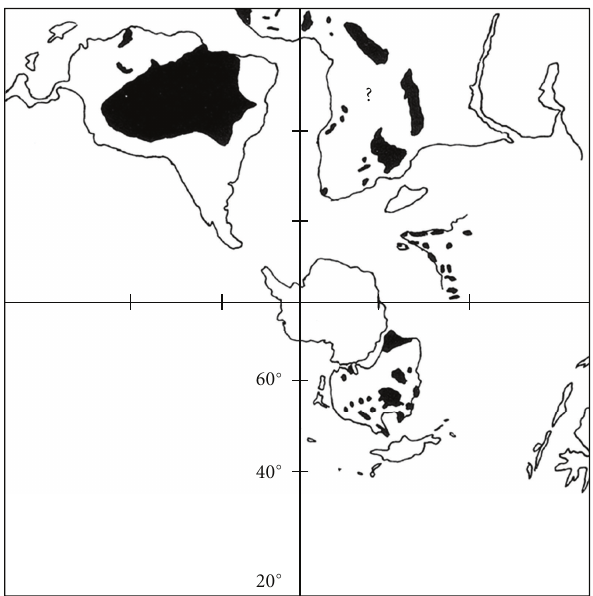
Figure 1: Distribution of lateritic soils (latosols) on the continental masses of Gondwanaland ([9–11], see [5, Figure 6.3]). The location of the Gondwanan land masses in the Late Cretaceous, 80 million years ago, is shown on a stereographic projection of the Southern Hemisphere between latitude 20 ◦ S to the South Pole